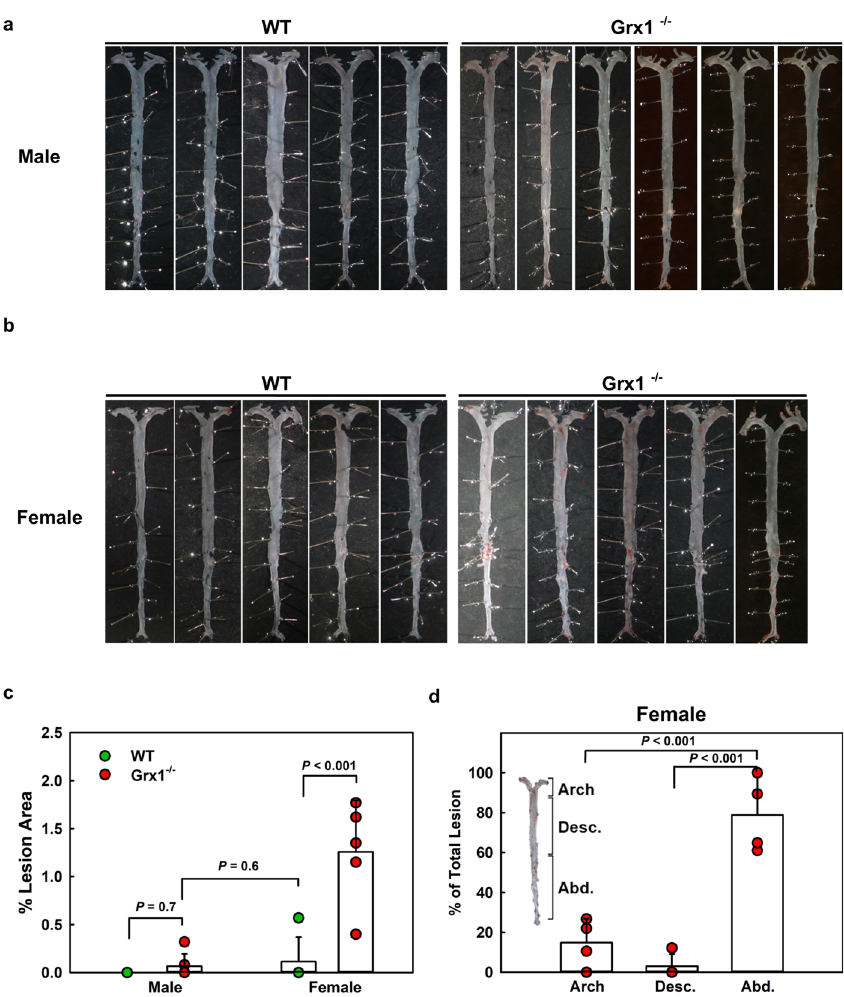
Fig. 3 Grx1 de fi ciency in chow-fed aged female Grx1 -/- mice promotes atherosclerotic lesion formation. a, b Images of Oil Red O-stained aorta from male and female 18-month-old Grx1 -/- Mice and age-matched male and female C57BL/6 J mice fed a normal chow. c Quantitation of aortic lesion area. n = 5 – 6 mice per group. d Distribution of lesions between aortic arch, descending aorta and abdominal aorta in female Grx1 -/- mice, n = 5 mice per group. All data are expressed as mean ± S.D. One-way ANOVA followed by Fisher ’ s Least Signi fi cance Difference test was used to compare the mean values between experimental groups. Source data are provided as a Source Data fi